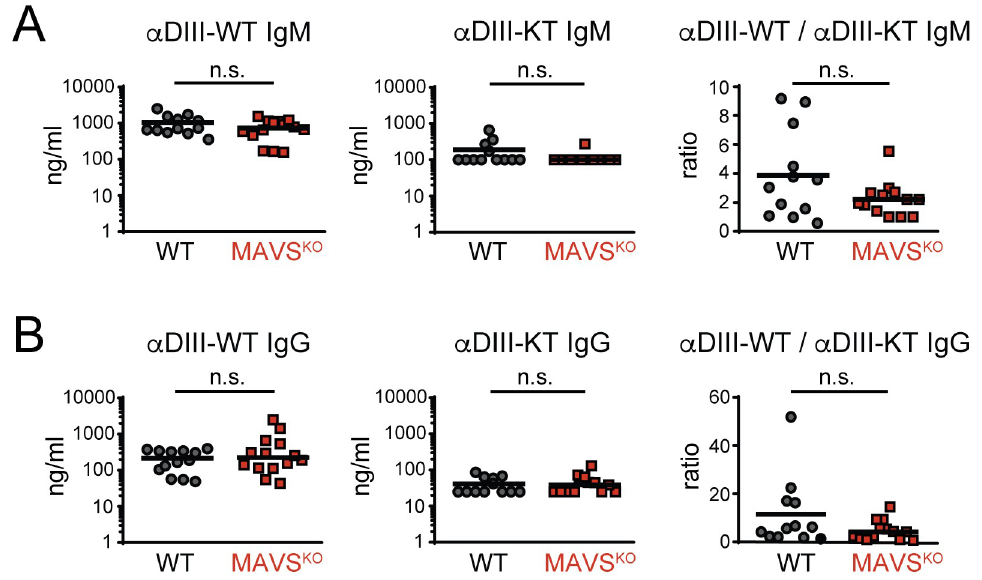
Fig 6. Normal specificity of the antibody response of MAVS KO mice to the neutralizing lateral ridge (LR) epitope in the WNV-E DIII domain. (A, B) The antibody response of RWN-infected MAVS KO and MAVS WT mice was measured 8 days post infection. Shown are the titers of IgM (A) and IgG (B) specific for the WT DIII domain or the mutant form DIII-KT containing loss-of-function mutations in the neutralizing LR epitope (DIII-K307E/T330I). Ratios represent the excess of antibodies directed at the neutralizing epitope over the amount of non-neutralizing antibodies directed at the DIII domain. Combined data of 4 experiments. Each data point is one mouse, the line is the median; n.s., not significant; Mann-Whitney